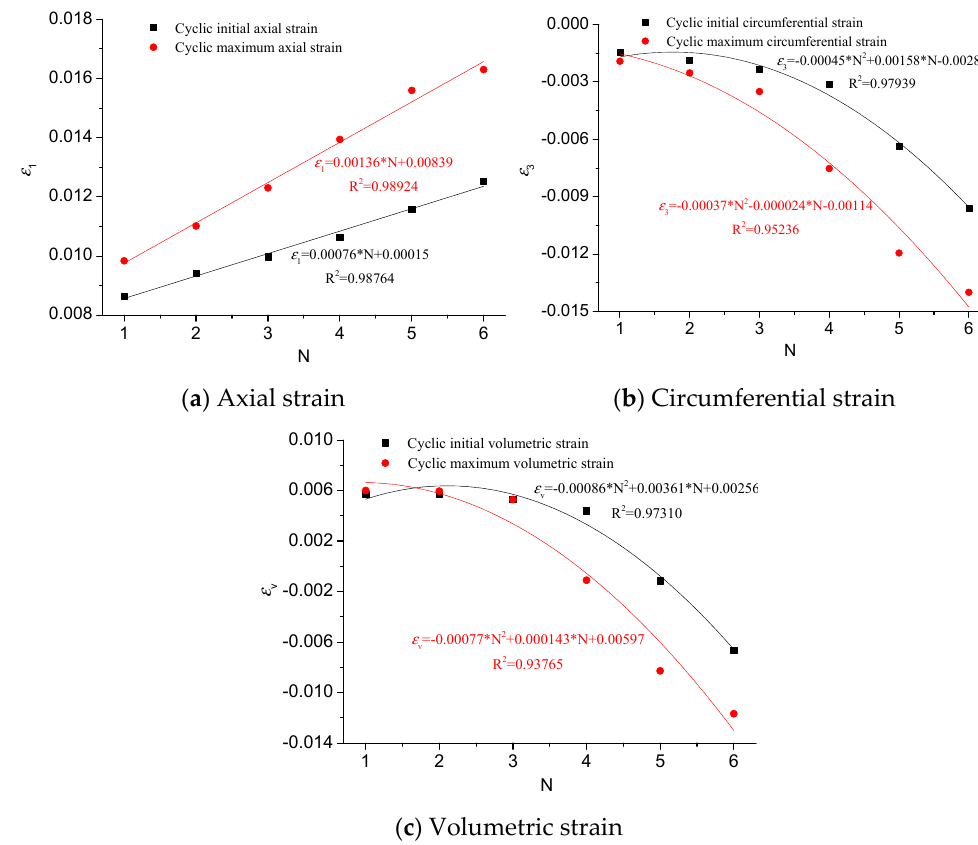
Figure 3. Relation curves between axial, circumferential, and volumetric strains and cycle number.